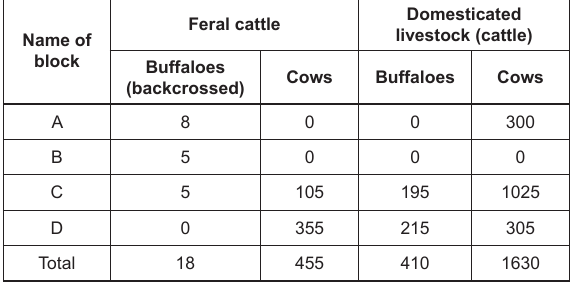
Table 7. Number of feral cattle recorded in 2011 Feral Name of block